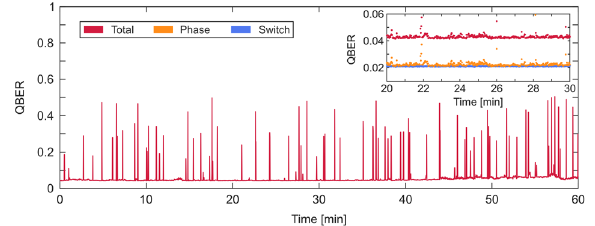
Fig. 3 System stability. Measured QBER in the X basis over one hour of continuous acquisition. Vertical lines show moments when the tracking system lost its locking position, yet recovering right away the previous stable QBER value. The inset shows a magni fi ca- tion of the same acquisition from minute 20 to 30: in red the same measured QBER, with an average value 4.9%, and in orange and blue its two contributions due to errors in the phase modulation and stabilization (average 2.8%) and to the switch modulation (average 2.1%), respectively.